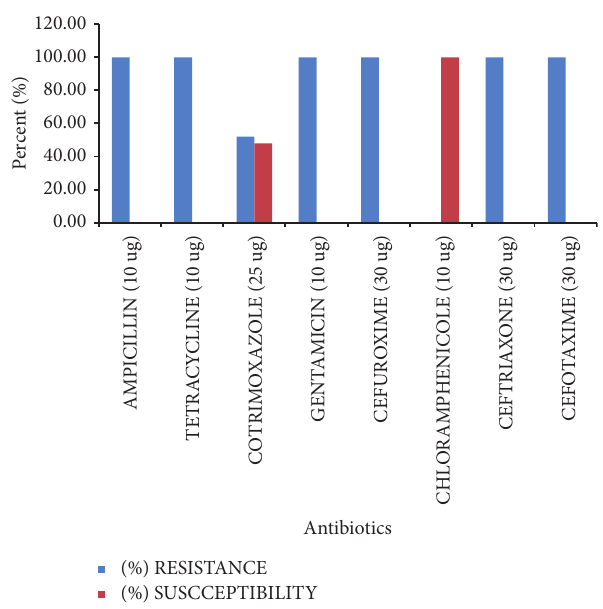
Figure 2: A graph showing percentage resistance and susceptibility of E. coli